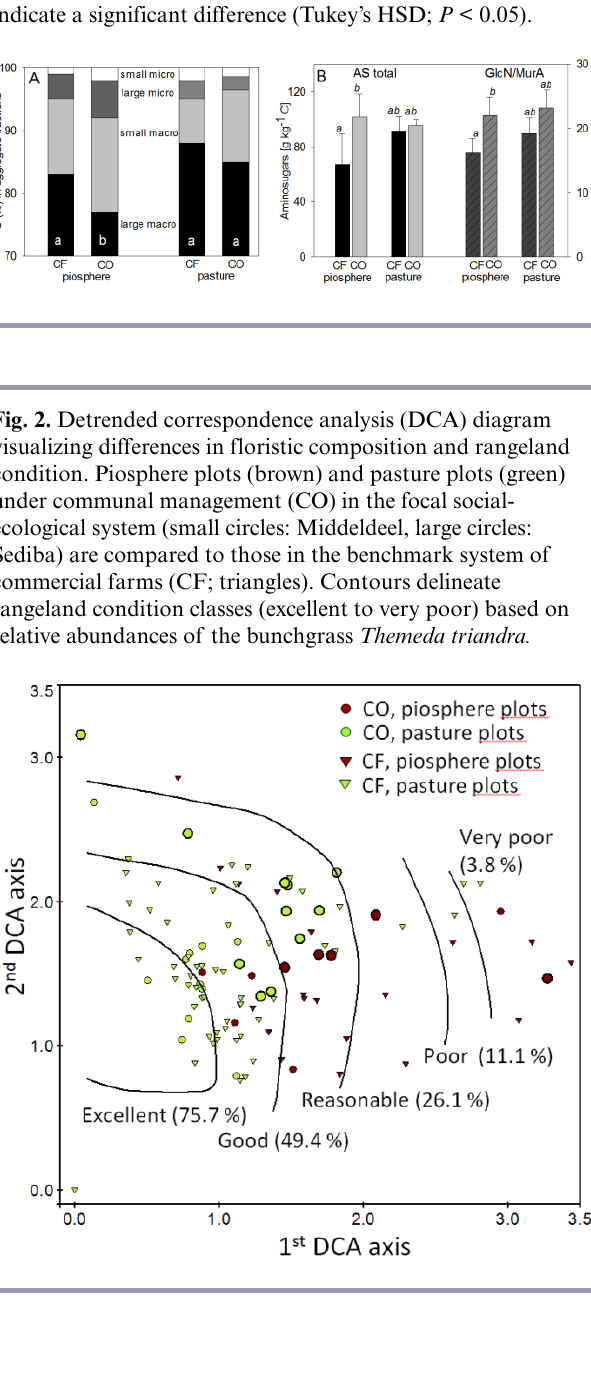
Fig. 1. Differences in topsoil condition of piospheres and pastures, comparing the focal social-ecological system with communal management (CO) to the benchmark of commercial farms (CF). (A) Organic carbon content (C) in aggregate fractions, expressed as percentage of total C in the respective aggregate class. (B) Total amino sugar concentration (AS total) and ratio of fungal- to bacterial-derived amino sugars (glucosamine to muramic acid, GlcN/MurA). Different letters indicate a significant difference (Tukey’s HSD; P < 0.05).